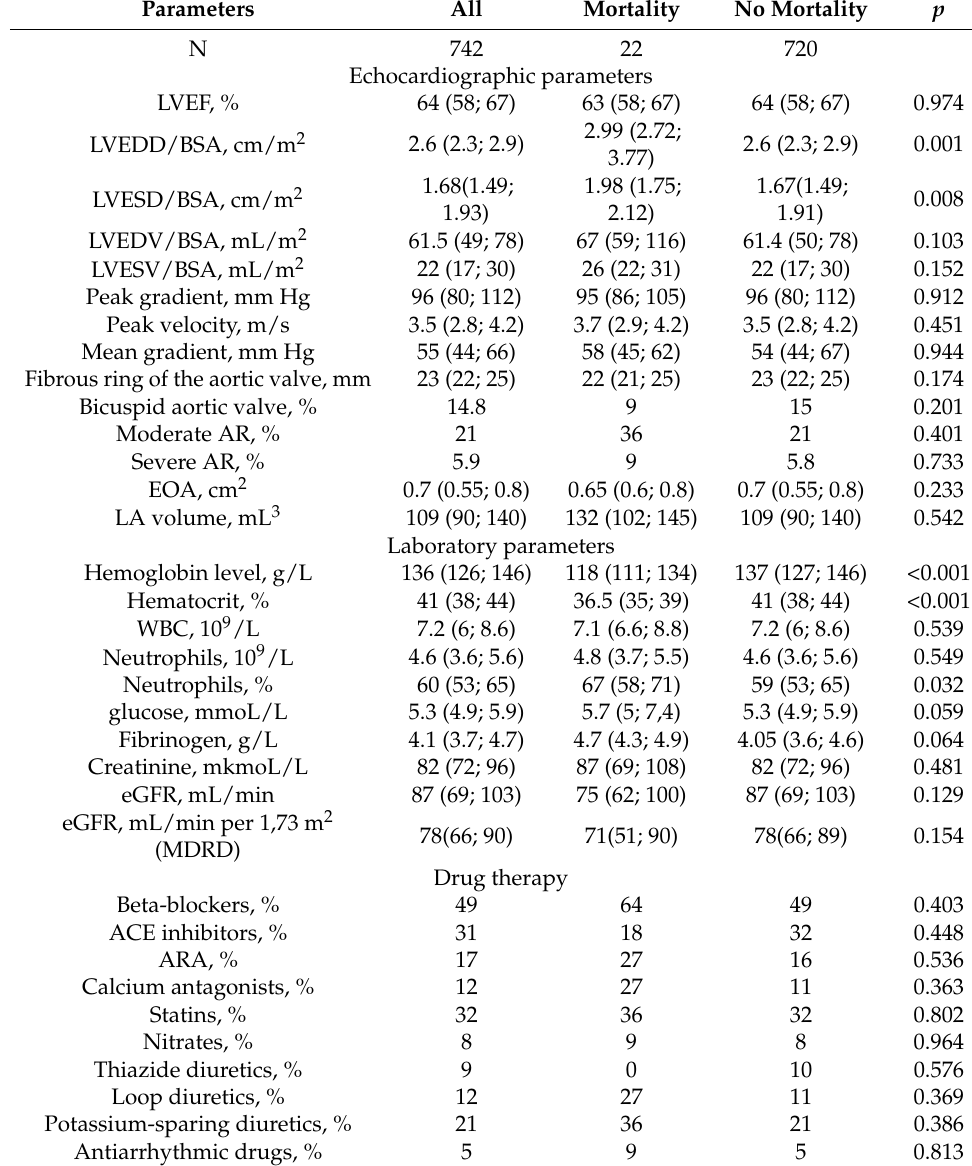
Table 2. Instrumental and laboratory characteristics of patients and drug therapy before surgery. Parameters All